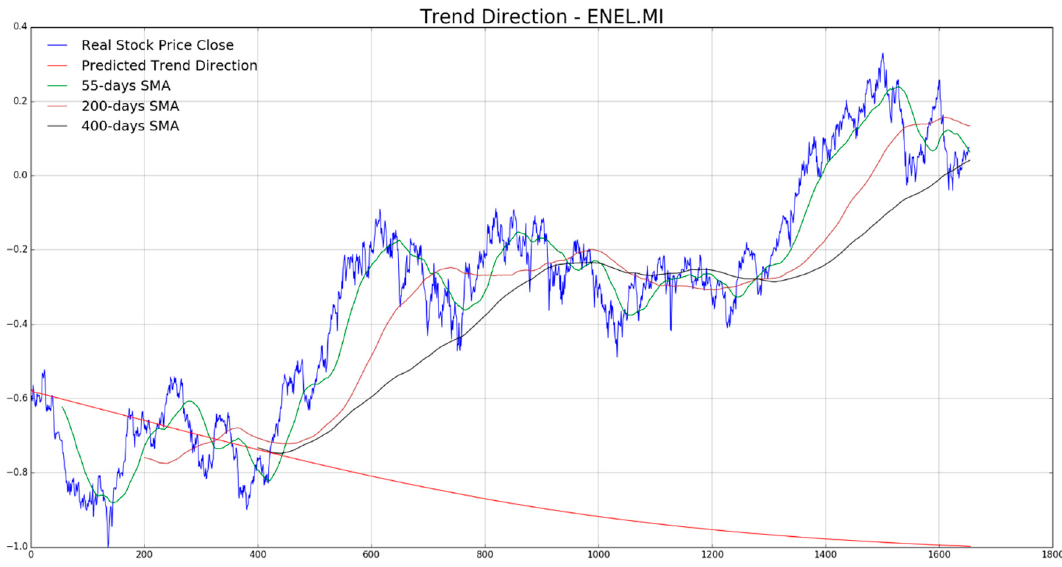
Figure 11. ENEL.MI Trend Direction (red) and SMA.